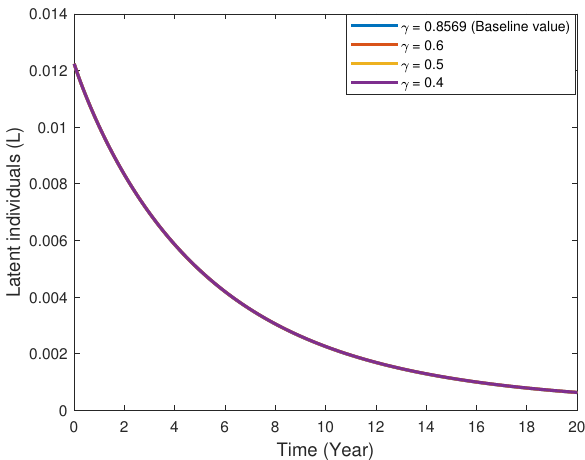
Figure 16. Behavior of L class for different γ values.